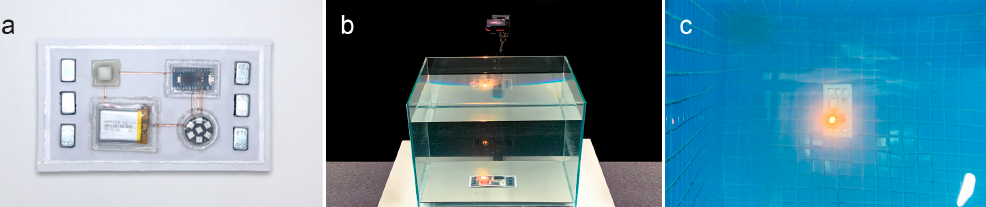
Figure 12. ( a ) Paper interface for waterproofing test; ( b ) 0.4 m depth water environment; and, ( c ) 1 m depth water environment.